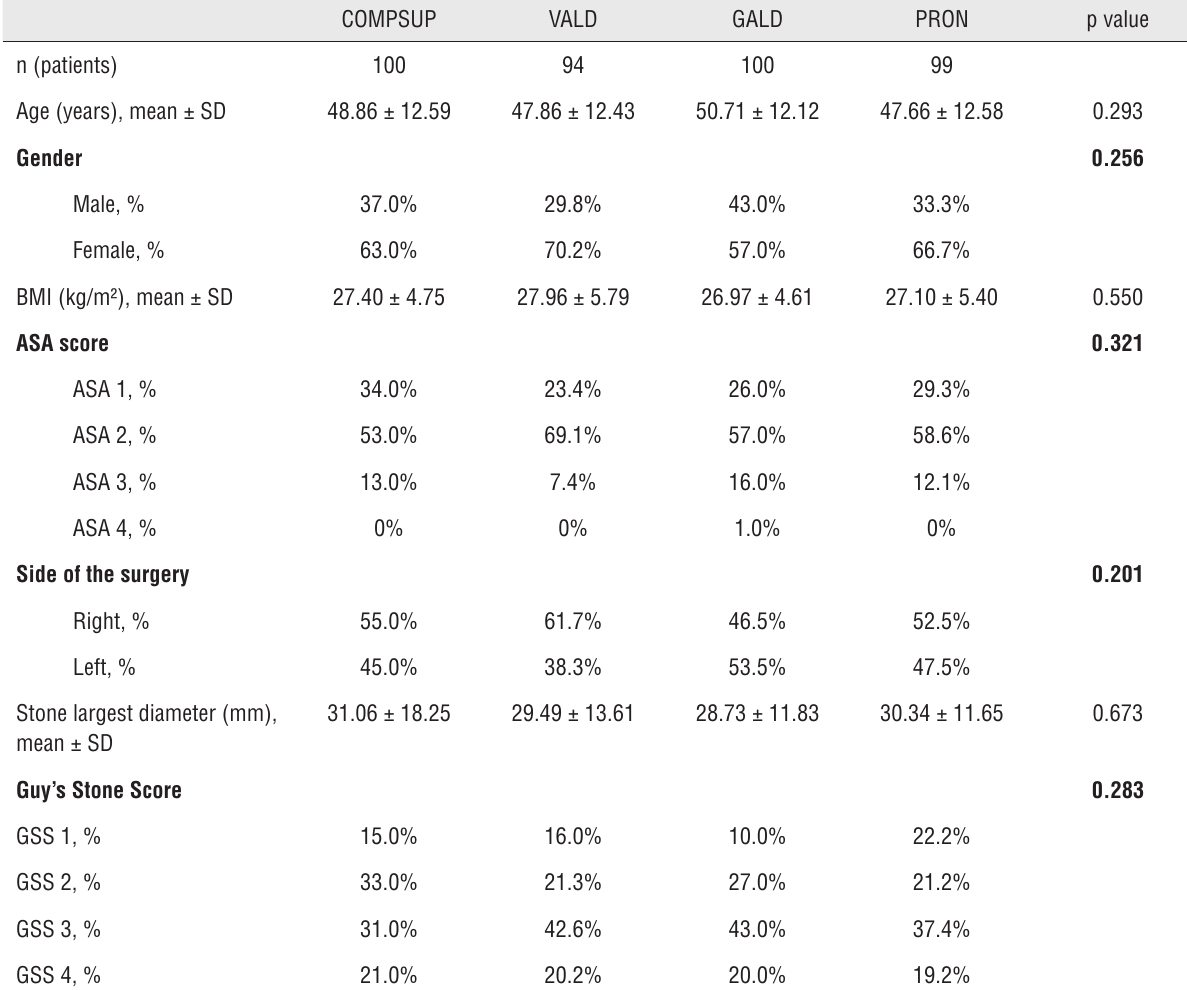
Table 1 - Baseline characteristics of patients undergoing